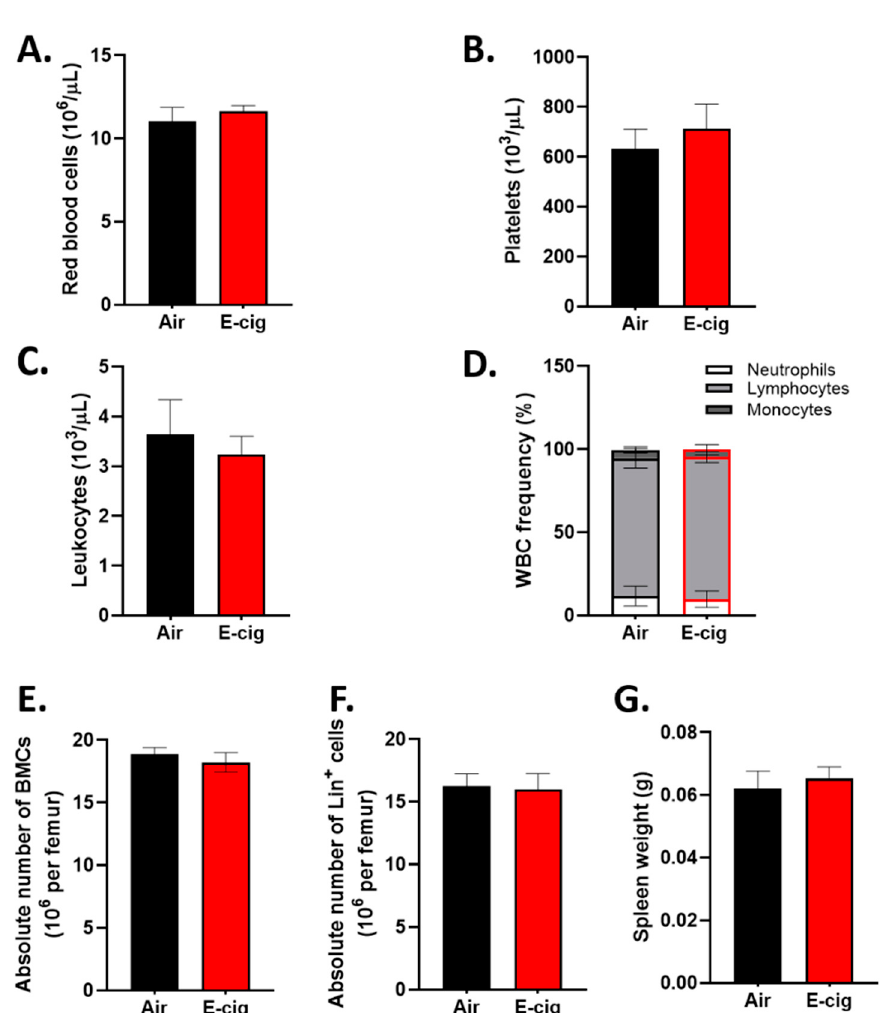
Figure 1. Two-month E-cigarette exposure does not affect peripheral blood cell counts of ( A ) red blood cells, ( B ) platelets, ( C ) leukocytes, and ( D ) leukocyte differentials in C57Bl/6J mice. ( E ) Bone marrow cellularity, ( F ) lineage positive cells, and ( G ) spleen weight after E-cigarette exposure in air and E-cigarette exposed mice. Data are shown as mean ± SEM, n = 4–7 mice / group. WBC, white blood cell; BMCs, bone marrow cells; Lin + , lineage positive.